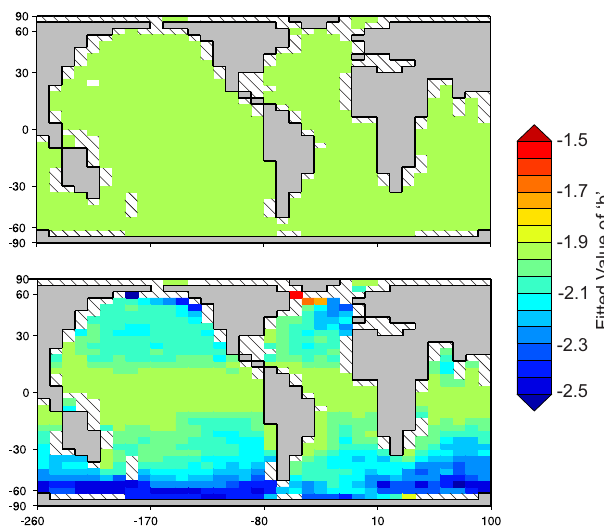
Figure 10. Assessment of the uncertainty associated with dissolved organic matter when inferring flux profiles. Value of the exponent when fitting a power law to the water column remineralisation rates from (a) a model with remineralisation from only sinking particu- late and (b) a model with particulate and dissolved organic matter. A value of − 0.858 for the Martin curve was used in both models. All curves were fitted with an R 2 > 0 . 9. The exponent for the rem- ineralisation curve is equivalent to − 0 . 858 − 1. More negative values indicate a Martin curve that predicts shallower remineralisation in the water column. Hatched areas indicate where the water column contained too few boxes to fit a remineralisation curve ( n <